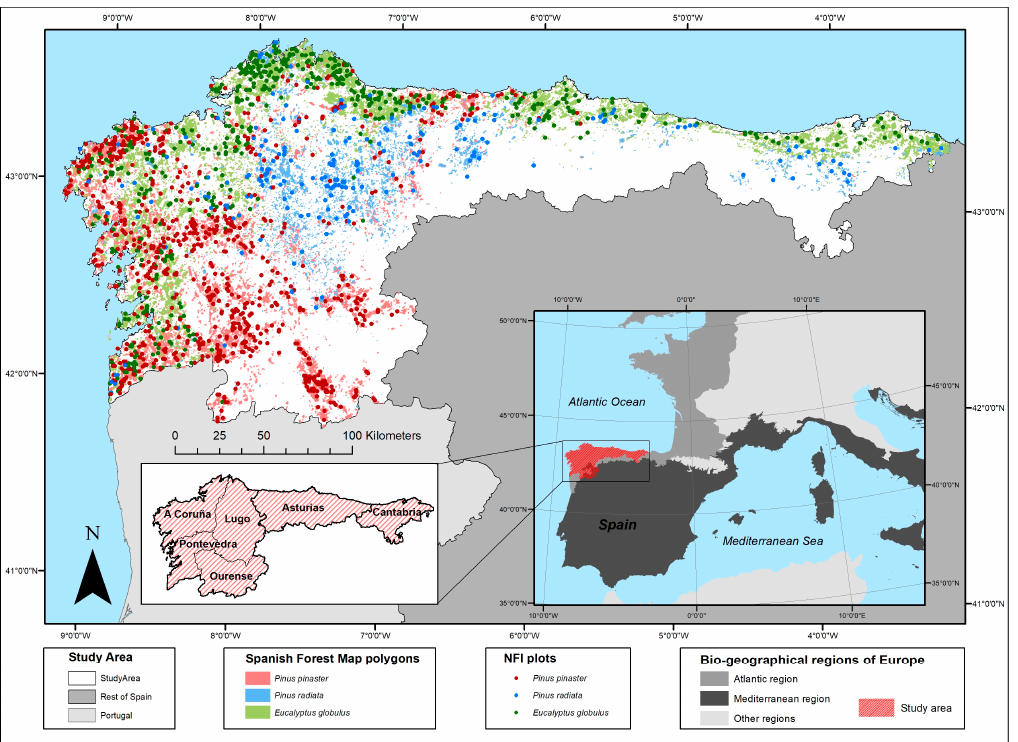
Figure 1. Location of the study area and National Forest Inventory plots and Spanish Forest Map polygons dominated by the three major commercial tree forest species ( Eucalyptus globulus , Pinus pinaster and Pinus radiata ) in in north-western Spain.